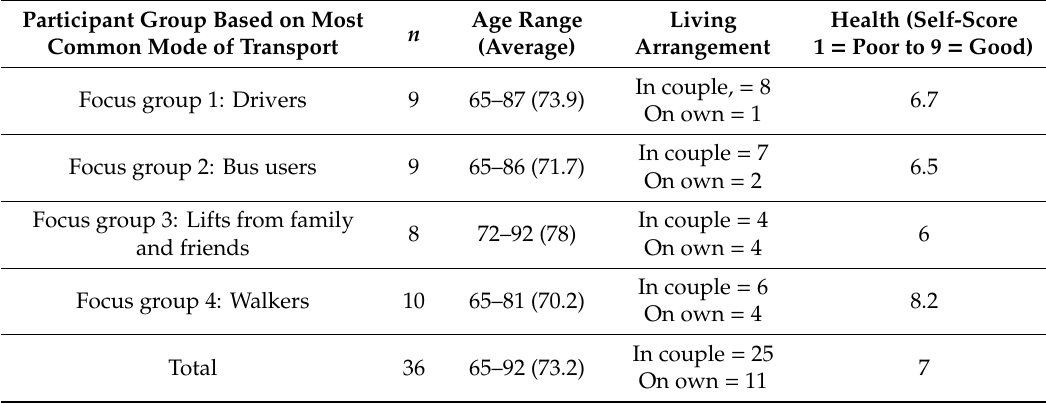
Table 1. Background of participants in the study by type of transport commonly